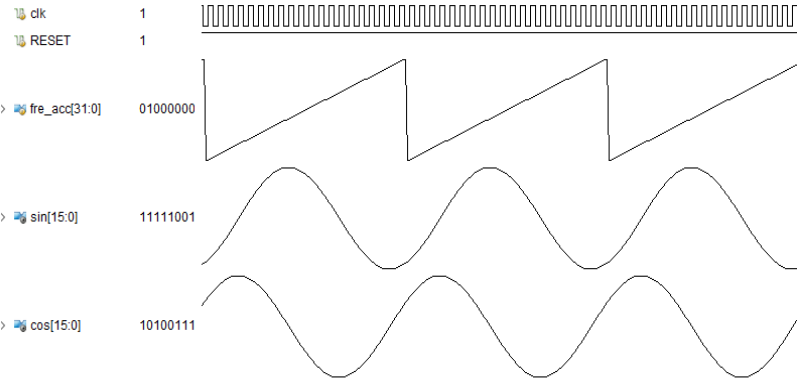
Figure 6. Simulation waveforms of calculated sine and cosine functions.